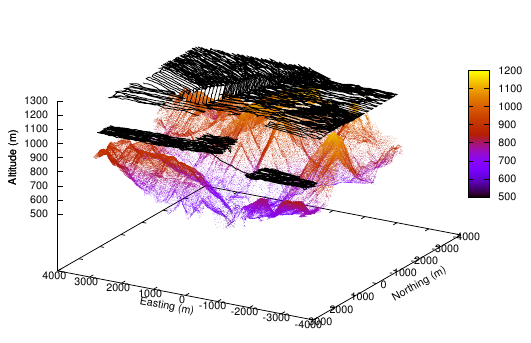
Figure 7. Ground acquisition in Marseille port. Recovered trajectory (black line) and tie point positions (red dots), with a closeup of one